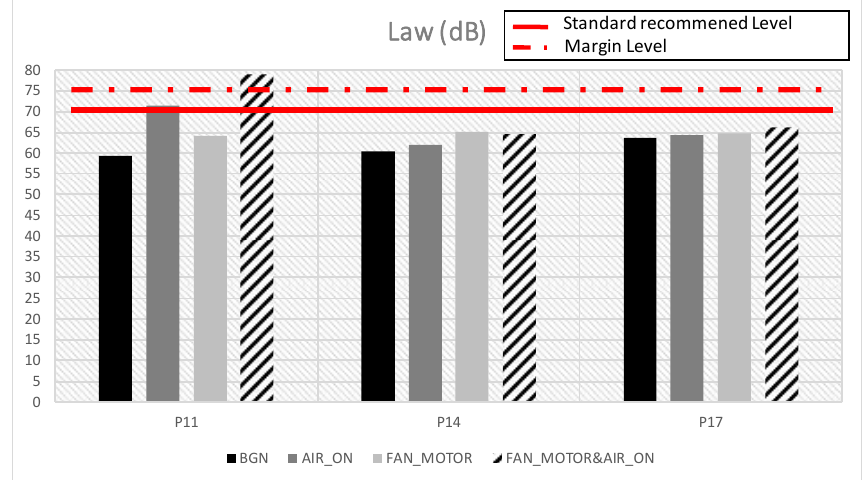
Figure 8. Average La w (dB) levels comparative. Positions 11, 14 and 17. FAN_Motor&Air Scenario.